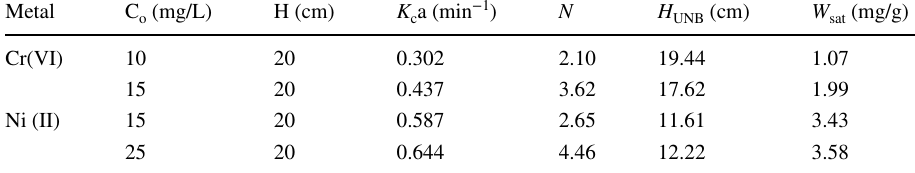
parameters for the dynamic